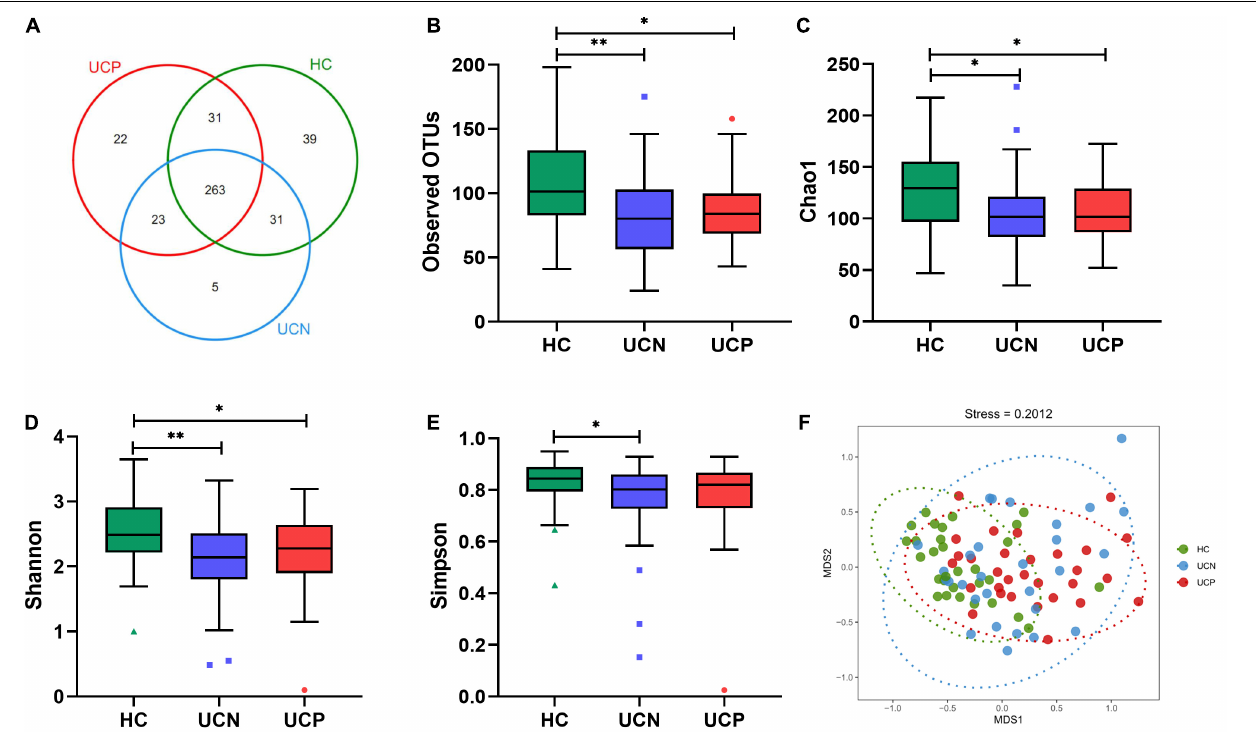
FIGURE 1 | Comparison of gut microbial structure among the HC, UCN, and UCP groups. (A) The Venn diagram shows the overlapping OTUs from the gut microbiomes of the three groups. (B–E) Alpha-diversity indices (the box plots of observed OTUs, Chao1, and the Shannon and the Simpson indices) among the three groups. ∗ P < 0.05, ∗∗ P < 0.01. (F) Beta-diversity index (plots of NMDS) among the three groups. HC, healthy control group; OTUs, operational taxonomic units; UCN, ulcerative colitis with negative Clostridioides difficile test results; UCP, ulcerative colitis with positive Clostridioides difficile